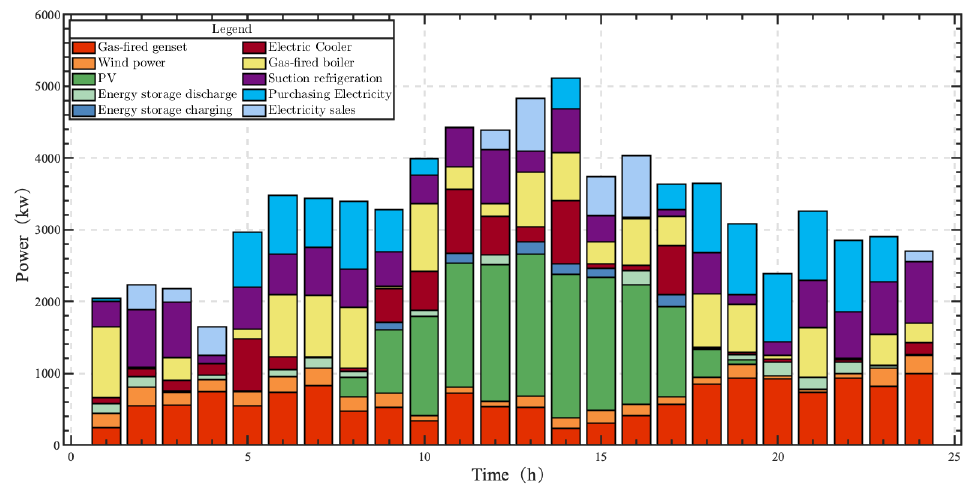
Figure 10. Volume of tradable electricity and electrical units operation with the opportunity strat- egy.